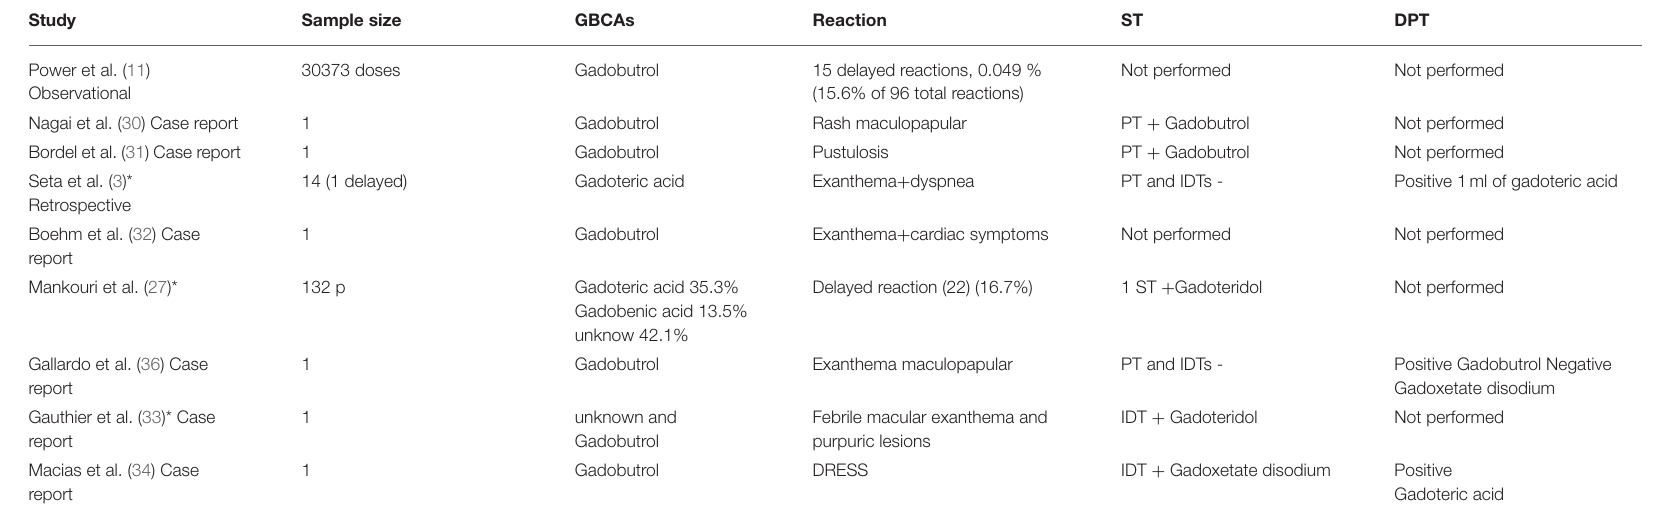
TABLE 3 | Non-immediatehypersensitivity reactions to